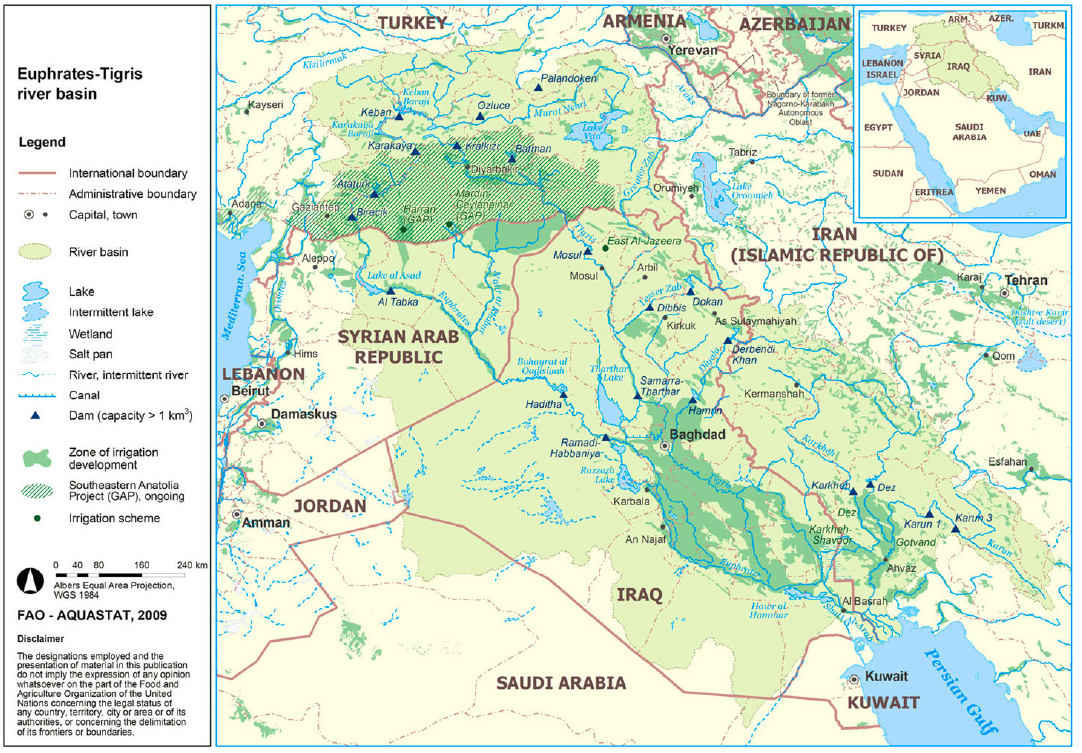
Figure 1. Euphrates—Tigris River Basin. (FAO-AQUASTAT: AQUASTAT Main Database, Food and Agriculture Organization of the United Nations 2009) [67].